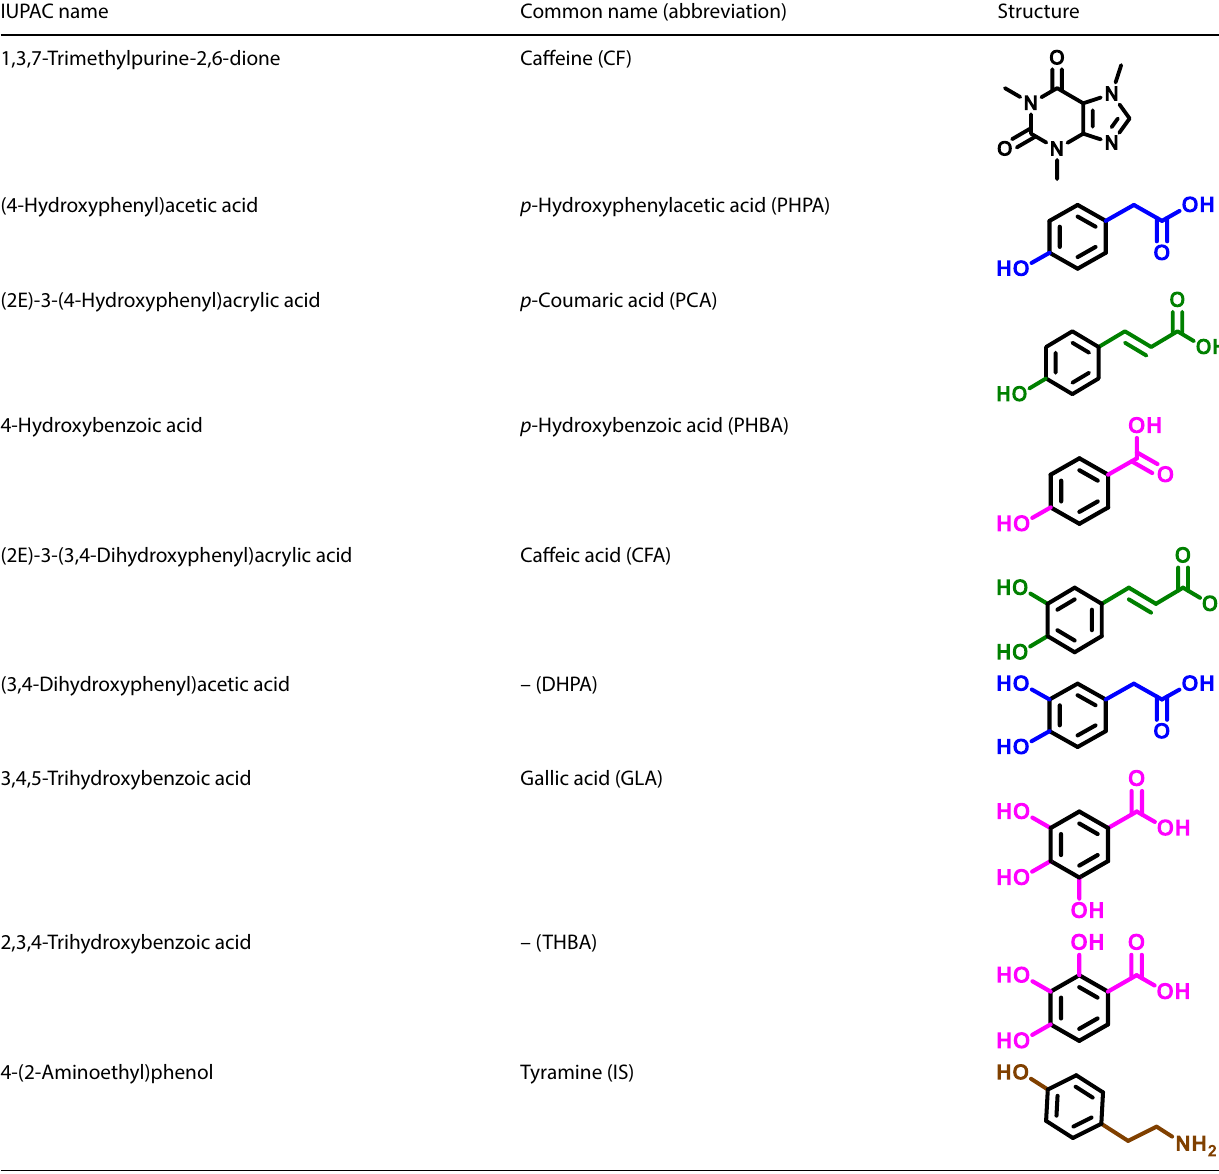
NOTE: GLA and THBA are